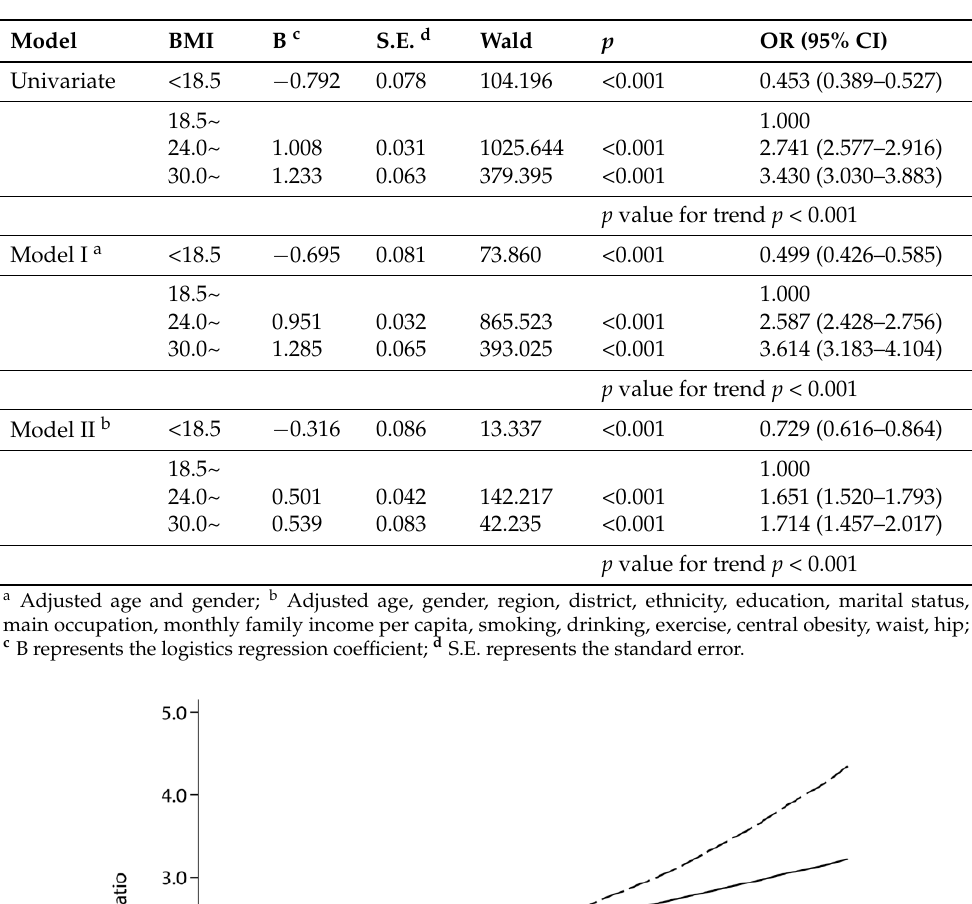
Table 3. Logistic regression analyses of the influence of BMI on hyperlipidemia prevalence.